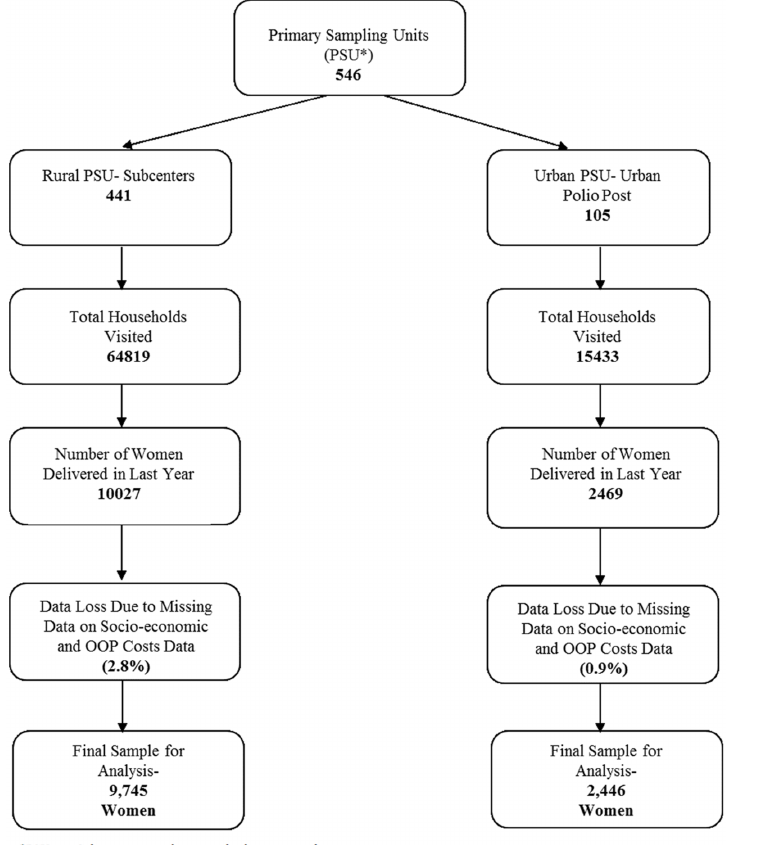
Fig 1. Flow Diagram Showing the Description of Data